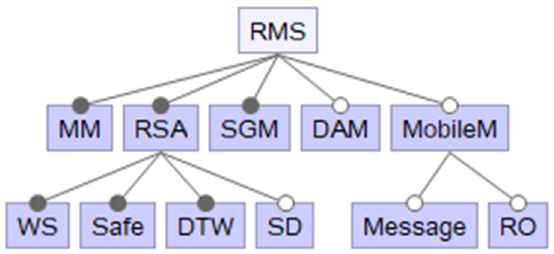
Figure 9. Evolved feature model.